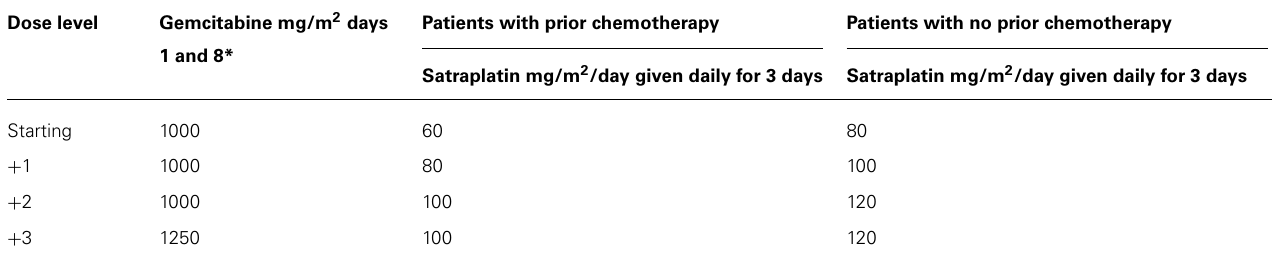
Table 2 | Dose escalation in part 2 study (every 21-day